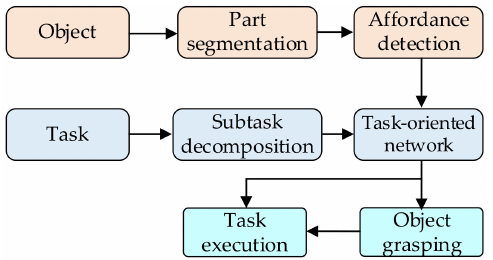
Figure 10. Functional flowchart of object grasping based on the task.